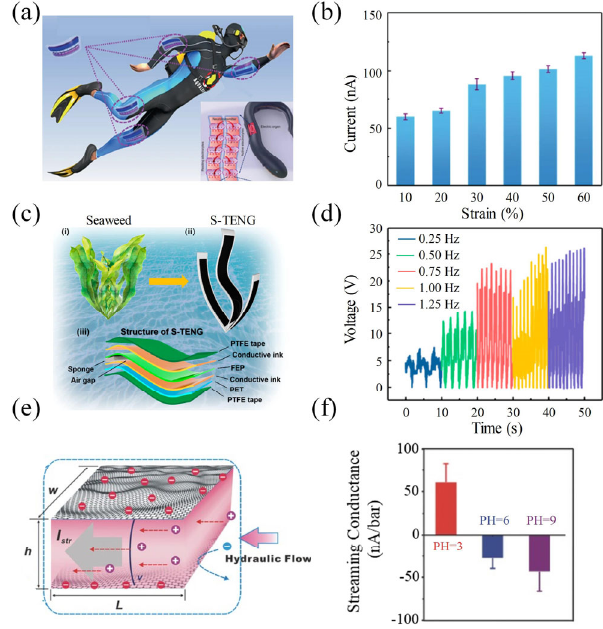
Figure 7 Bio-inspired water-driven sensor. (a) Schematic diagram of an underwater wearable sensor. (b) Relationship between the output current of an underwater wearable sensor and the strain. (a) and (b)